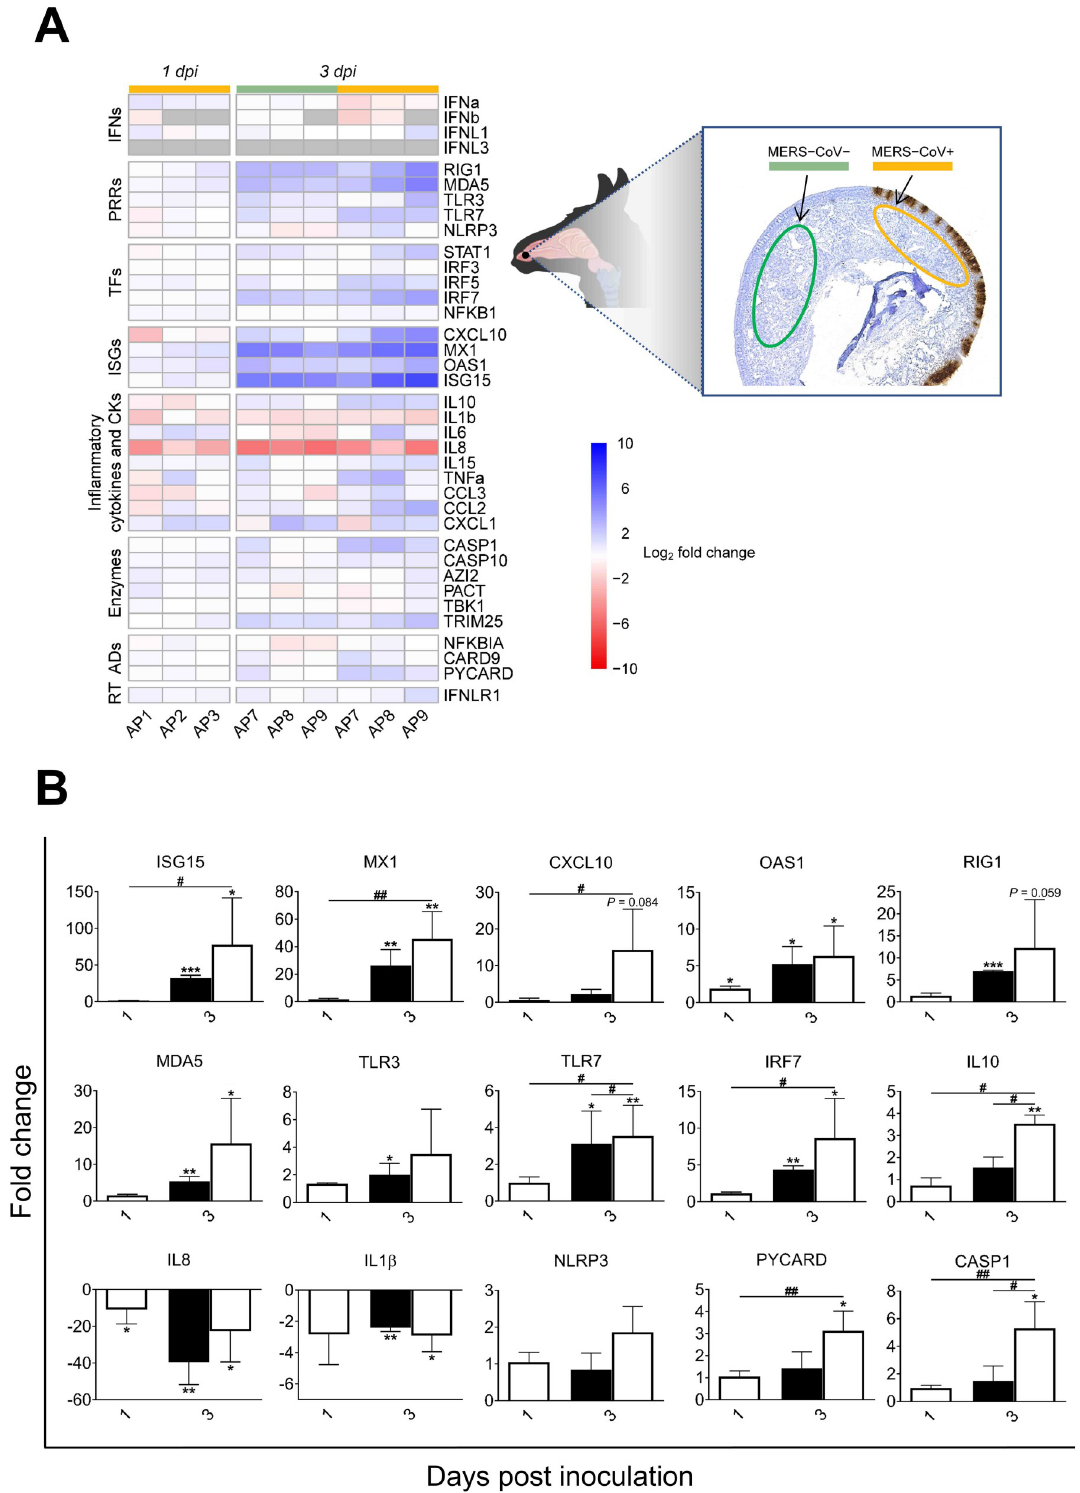
Fig 4. Kinetics of alpaca innate immune responses at the nasal submucosa in response to MERS-CoV Qatar15/2015. (A) The nasal submucosa of each alpaca (AP1, 2, 3, 7, 8, 9, 13, 14 and 15) was micro-dissected and areas underlying infected (orange)/non-infected (green) epithelium, as assessed by IHC (see the right panel), were selected and isolated for RNA extraction and conversion to